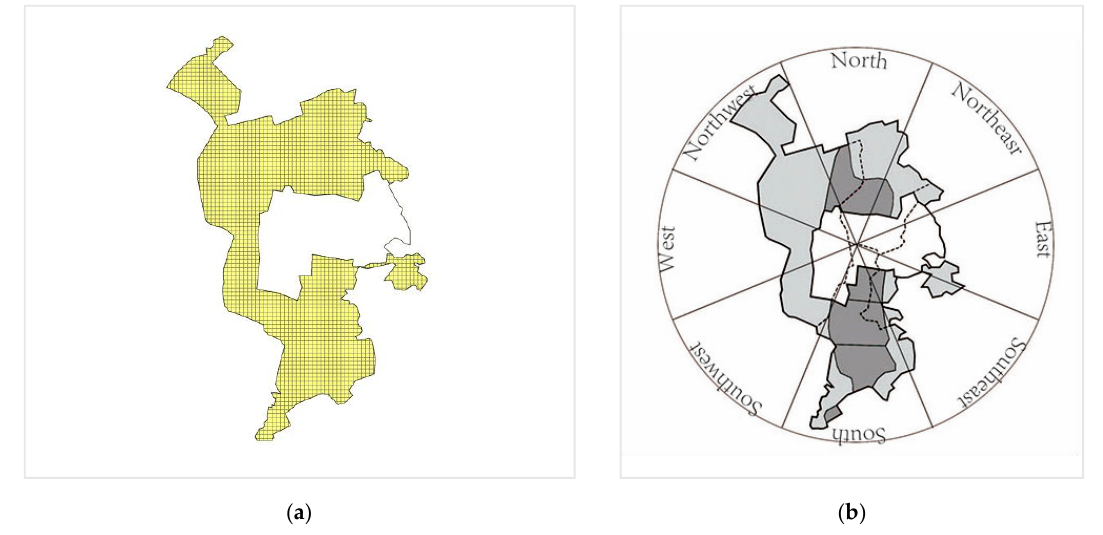
Figure 4. Determination of the area of analysis ( a ); 1 × 1 km assessment unit ( b ); quadrant division of the study area.